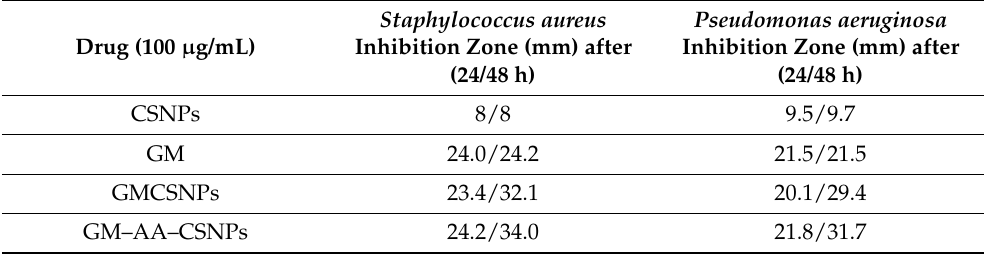
Table 1. Diameters of inhibition zones of free and loaded drugs against Staphylococcus aureus and Pseudomonas aeruginosa.